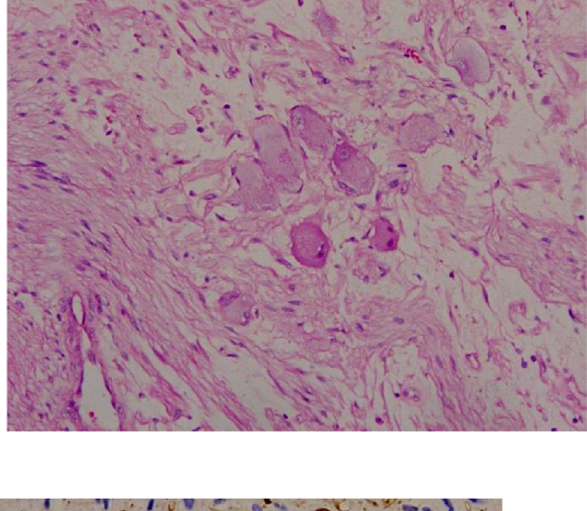
Fig. 3 Histopathology of ganglioneuroma. Microscopi- cally showed ganglion cells and Schwann cells (hematoxy- lin and eosin stain). Original magnification × 200